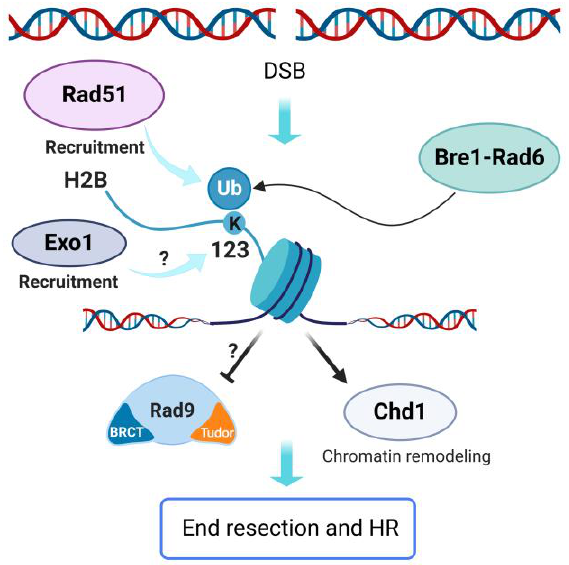
Figure 5. Ubiquitylation of histone H2B promotes HR in S. cerevisiae . Bre1-Rad6-dependent ubiquitylation of H2B K123 supports Rad51 loading on resected ends. It also regulates chromatin remodelers like Chd1, thus promoting chromatin accessibility and resection. Finally, H2B K123 ubiquitylation could promote resection by inhibiting Rad9 recruitment and increasing Exo1 association to the DSB ends. Created with BioRender.com.